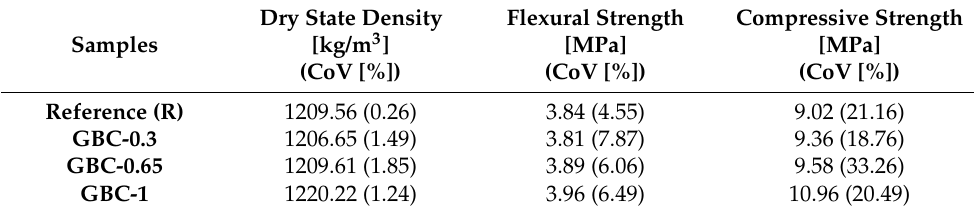
Table 6. Summary table with all the test results obtained for gypsum